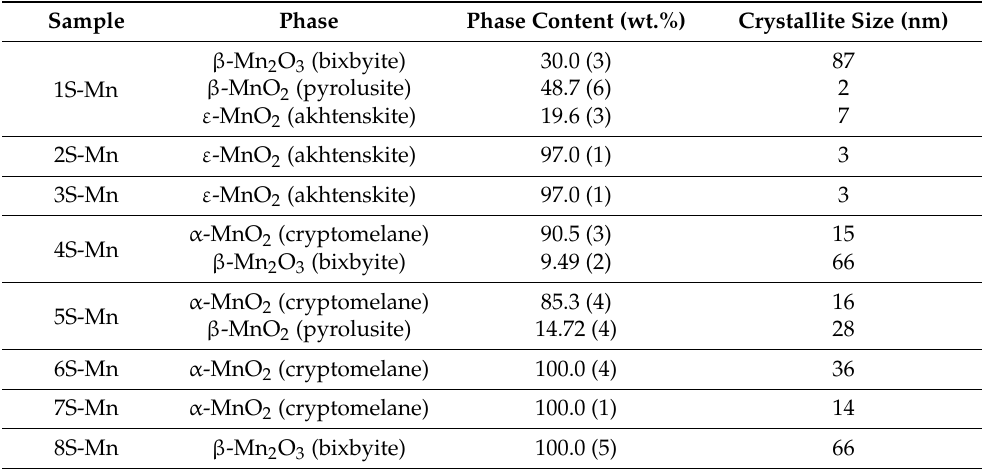
Table 1. Phase compositions and phase parameters for the manganese oxide samples under